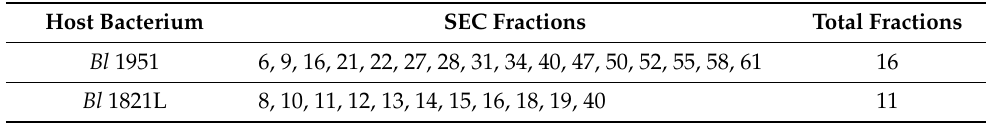
Table 2. Bl 1951 SEC active fractions of the assay